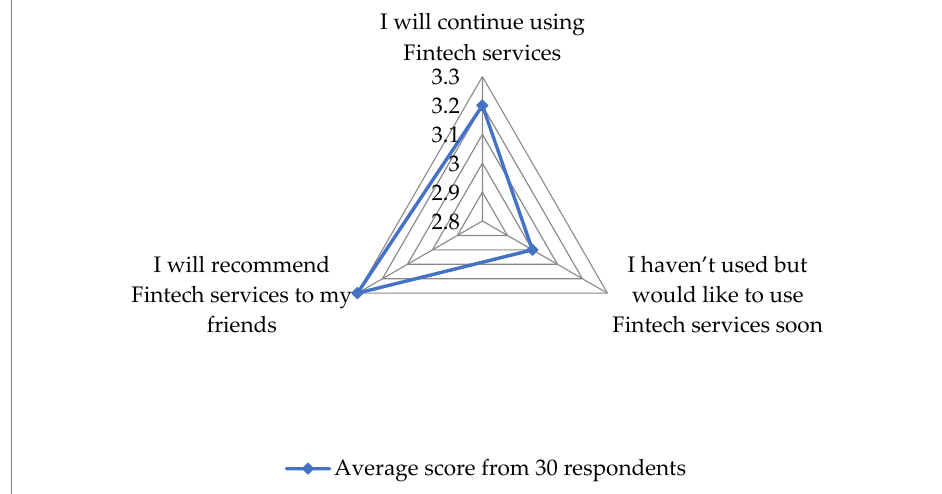
16 and 17 presents the analysis. Table 16. Comparing Gender means for all Research Variables.